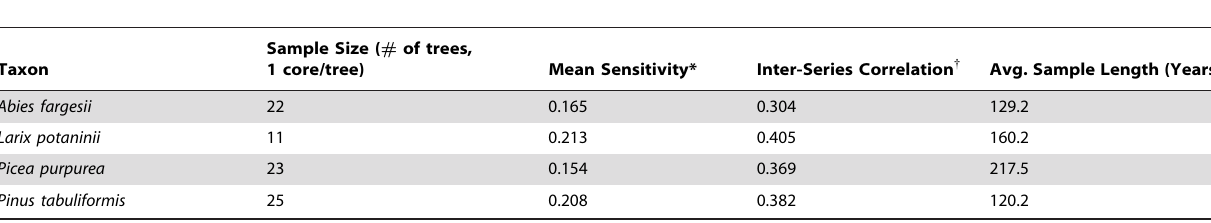
Table 2. Tree-ring descriptive statistics for four conifer species from Jiuzhaigou National Nature Reserve used in dendroclimatological analyses.